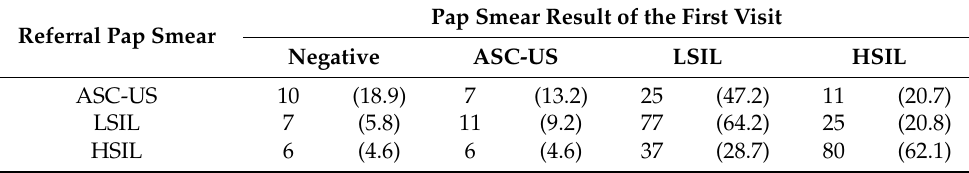
Table 2. Correlation between the Pap smear result of the referral visit and the Pap smear result of the first visit performed at the Colposcopy Unit.